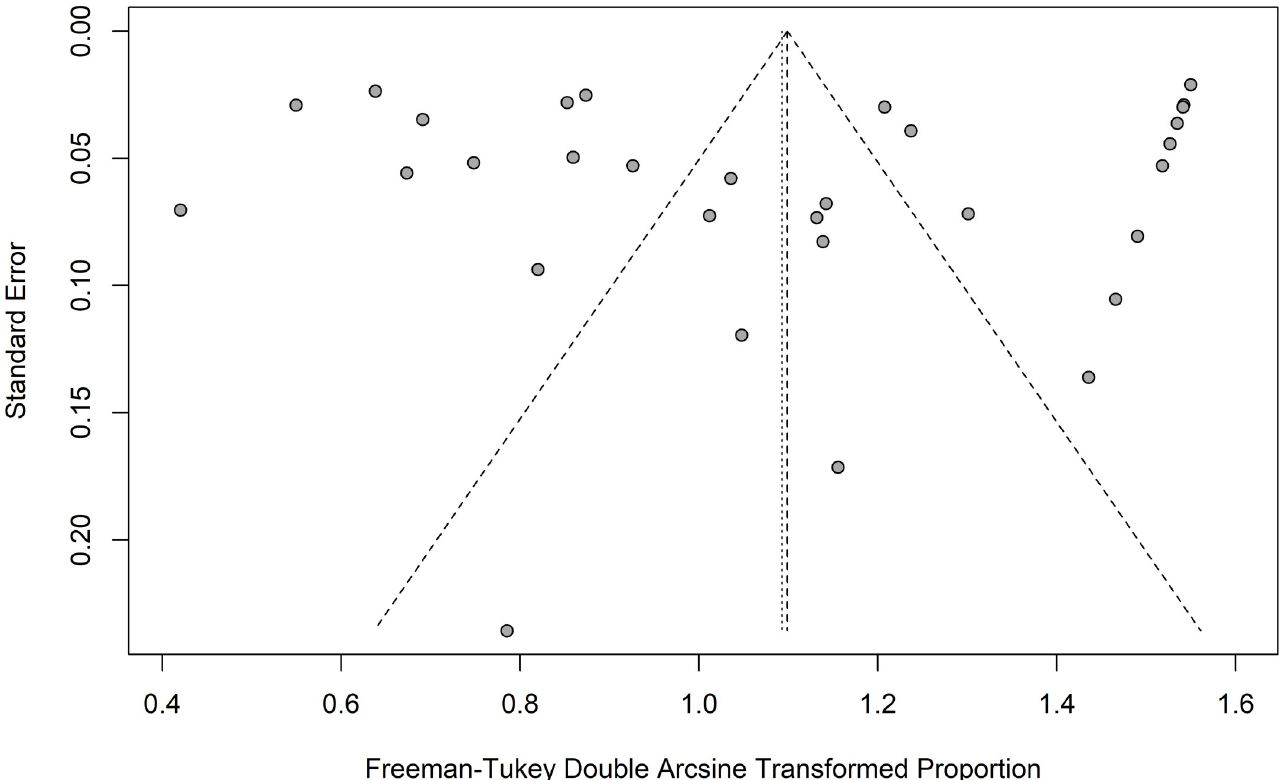
Fig 3. Funnel plot of the meta-analysis on the biofilm formation rate in Candida spp. isolated from blood clinical samples. Studies are represented by a point. The X-axis represents the effect size (biofilm prevalence), and the Y-axis shows the standard error. Despite some asymmetry revealed by the funnel plot in the data set, Egger’s test failed to show publication bias ( p = 0.896).